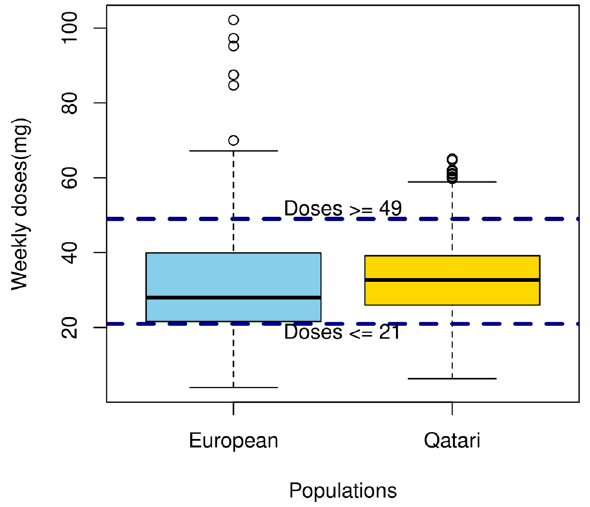
Fig. 3 Warfarin dosing prediction. Distribution of the predicted weekly dose (mg) of warfarin in the Qatari population (yellow) using the IWPC algorithm based on age, sex, height, weight, ethnicity, the concurrent use of drugs that decrease warfarin requirements, and the genotypes/diplotypes of VKORC1 and CYP2C9 . Also shown is the distribution of dosage in patients of European ethnicity from the EU- PACT trial (blue). Weekly doses in mg are plotted in the Y-axis for the two populations. The box is drawn with the interquartile range and the central horizontal line showing the median, while values above the range shown as whiskers. Individuals with values ≤ 21 mg per week (below the bottom horizontal line) would be predicted to need a lower dose, and those with values ≥ 49 mg per week (above the top horizontal line) would be predicted to need a higher